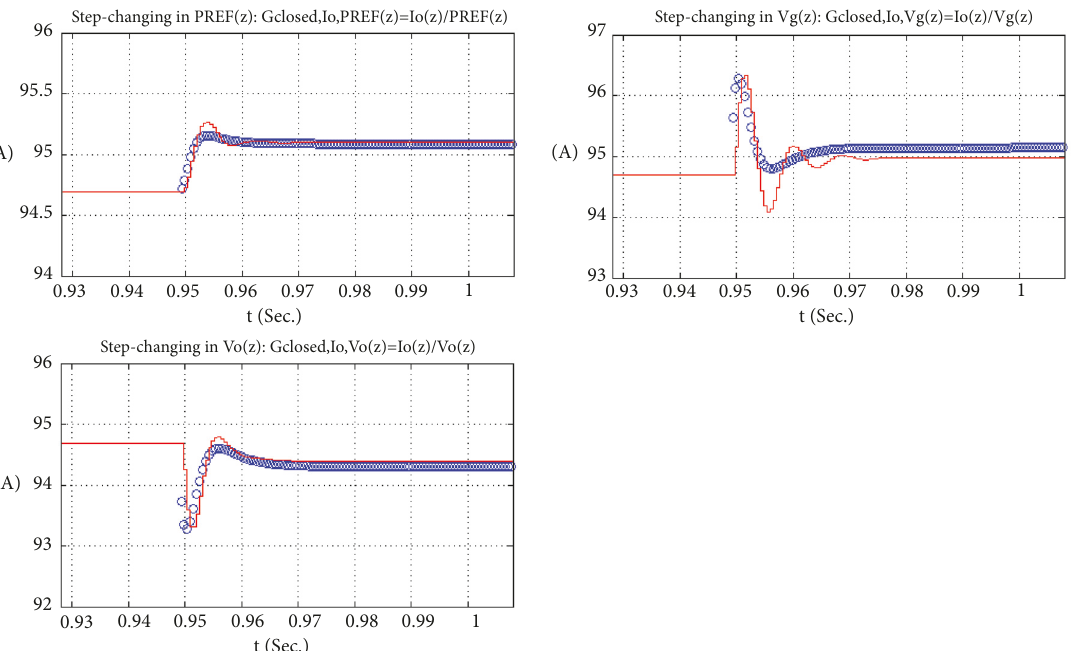
Figure 10: Dynamics of output current I generated by both the switching model and derived state-space model with the closed-loop o controller when +0.5% of step-changing is applied in P , V , and V , respectively ( 𝑃 푅퐸퐹 : 9.0MW 󳨀→ 9.045MW, V REF g o 󳨀→ 100.5kV , V : 100.0kV ; blue circle: dynamic of state-space model in z-domain, red line: dynamic of electrical signal 101.515kV DC DC DC o in PLECS circuit model, the interrupt time of digital controller: T =1/( 2 x 𝑓 푠 | ) =1/(2x900Hz) sec). op int